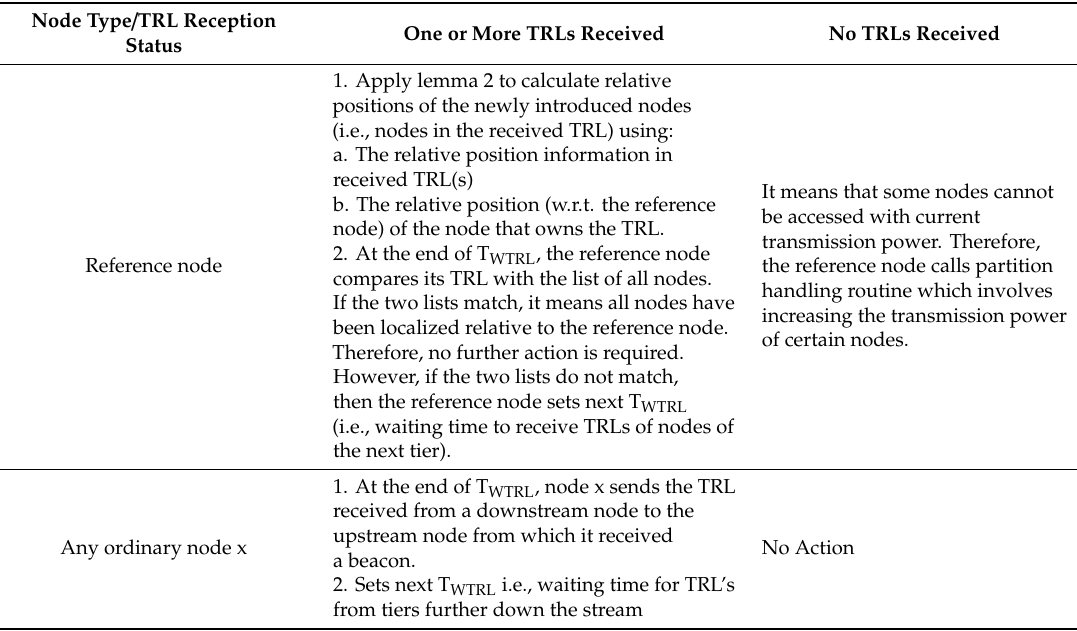
Table 2. Actions during and at the end of T WTRL